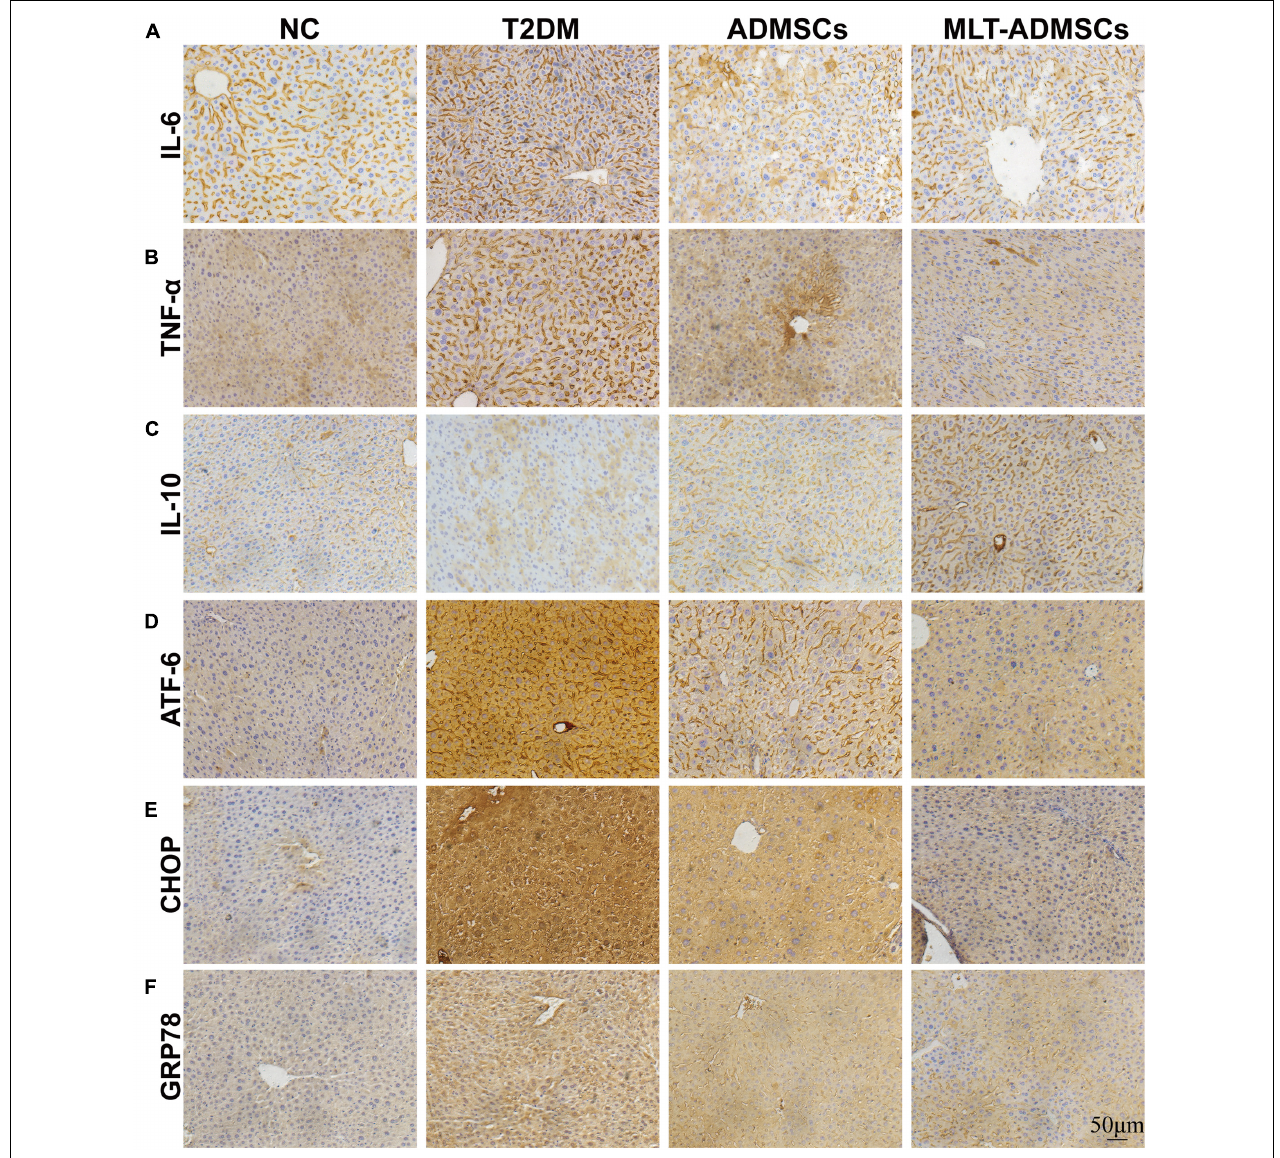
FIGURE 6 | MLT promotes the therapeutic effect of ADMSCs through stronger anti-inflammatory and anti-ER abilities to restore liver function. (A) Liver IL-6 expression. (B) Liver TNF- α expression. (C) Liver IL-10 expression. (D) Liver ATF-6 expression. (E) Liver CHOP expression. (F) Liver GRP78